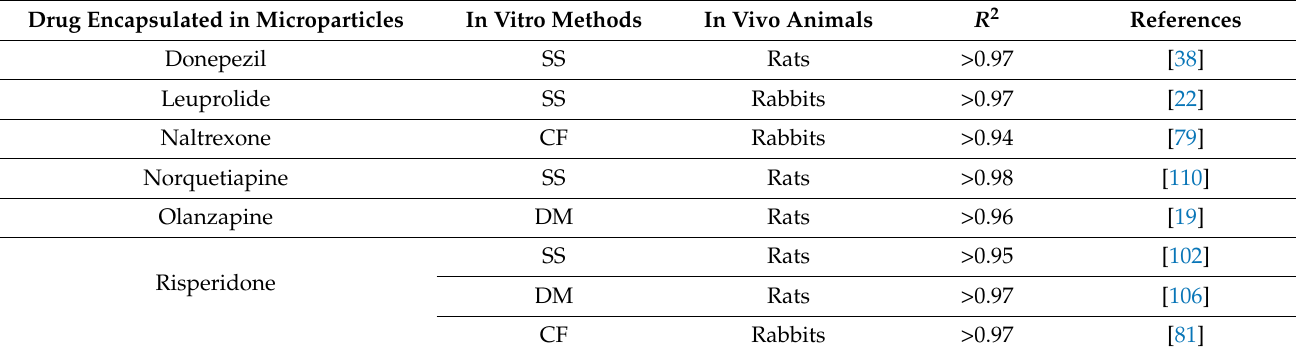
Table 4. Examples of Level A IVIVC of microparticulate formulations in animal models. Drug Encapsulated in